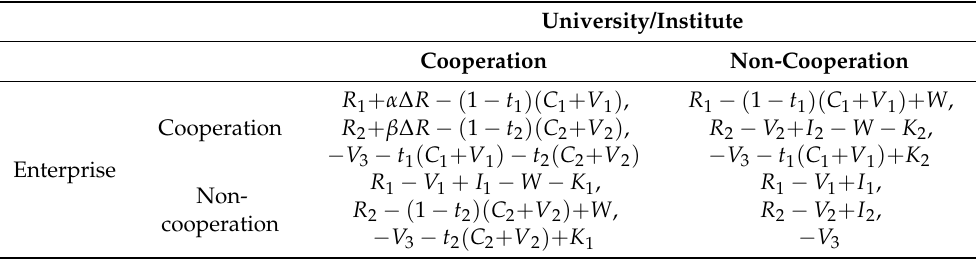
Table 1. Green technology collaborative innovation game payoff matrix of an enterprise and a uni- versity/institute with government participation.